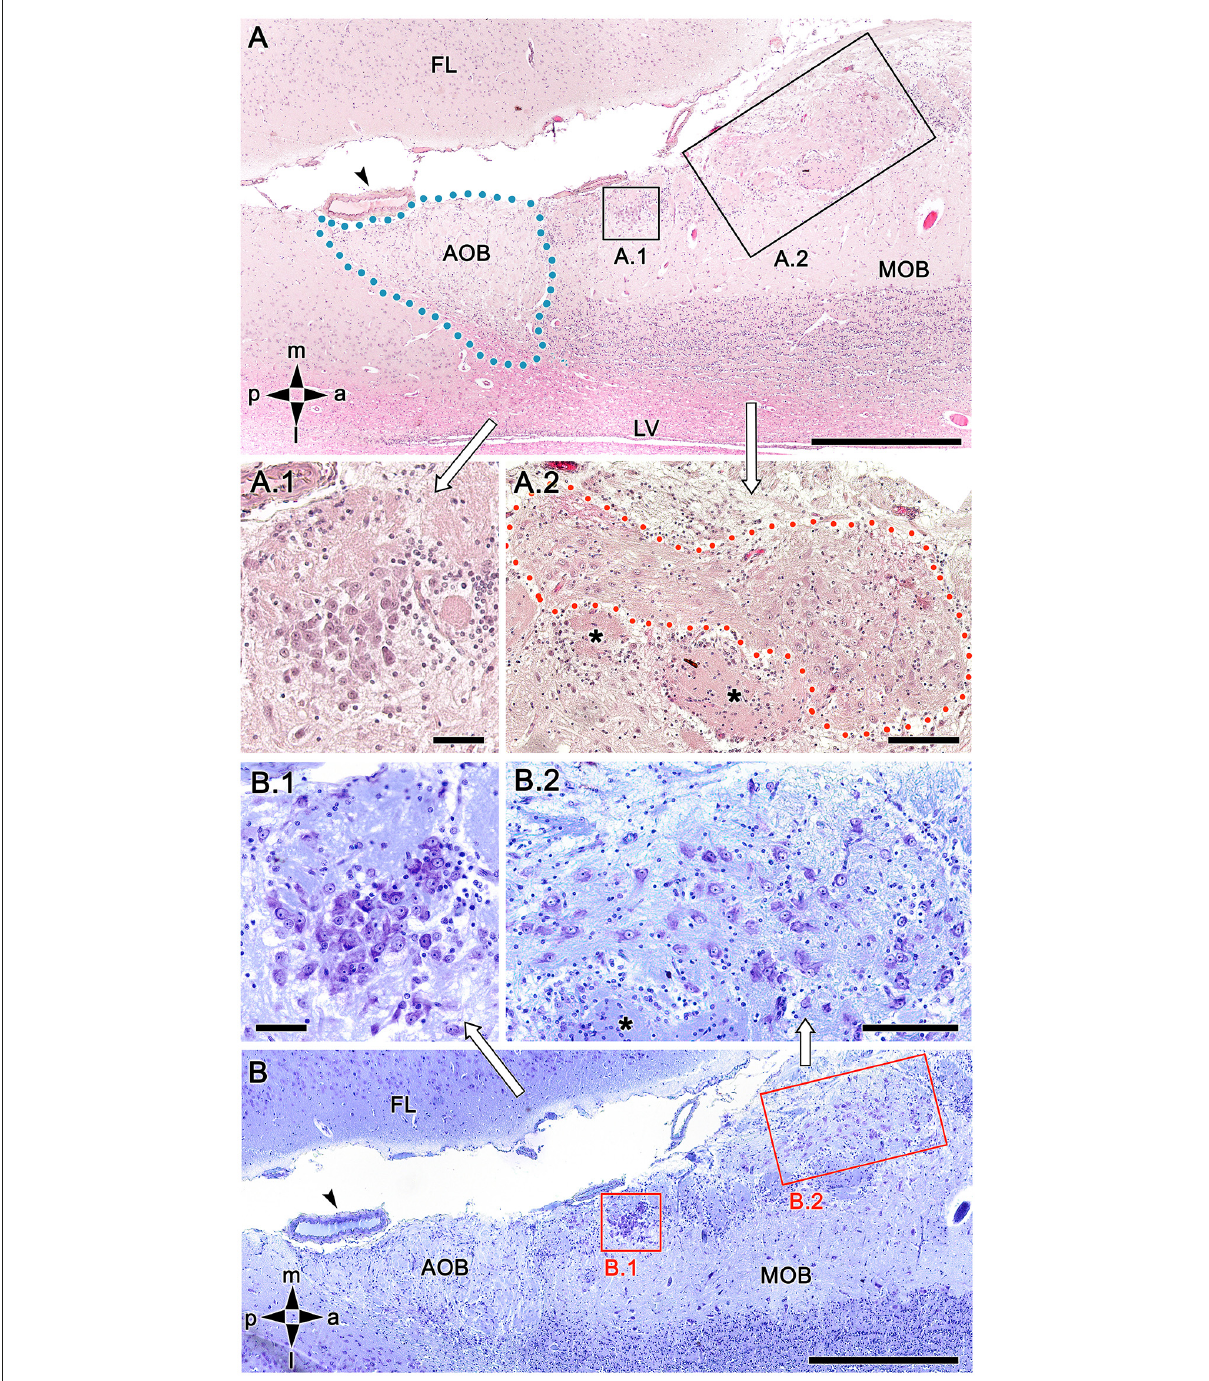
FIGURE3 Histological study of the fox olfactory limbus (OL). (A) General view of the OL, in the horizontal plane. The accessory olfactory bulb (AOB), close to a large artery (arrowhead), is framed by dots. The two most strikingly discernible features of the OL are framed and shown at higher magnification in (A.1) and (A.2) : the dense neuronal cluster (A.1) and the macroglomerular complex (MGC, delimited by red dots in A.2 ), a broad nervous formation consisting of neuronal somata distributed within a neuropil with clearly distinct boundaries. Small, irregularly shaped glomeruli were observed deep to both structures (asterisks). (B) Consecutive, Nissl-stained serial sections showing the morphology of the neuronal somata. Both the denser aggregates (B.1) and the MGC (B.2) , possess polygonal, ellipsoidal, and rounded somata. FL, frontal lobe; LV, lateral ventricle; MOB, main olfactory bulb. Orientation: m, medial; l, lateral; p, posterior; a, anterior. Scale bars: (A,B) : 500 µ m. (A.1,B.1) : 100 µ m. (A.2,B.2) : 250 µ